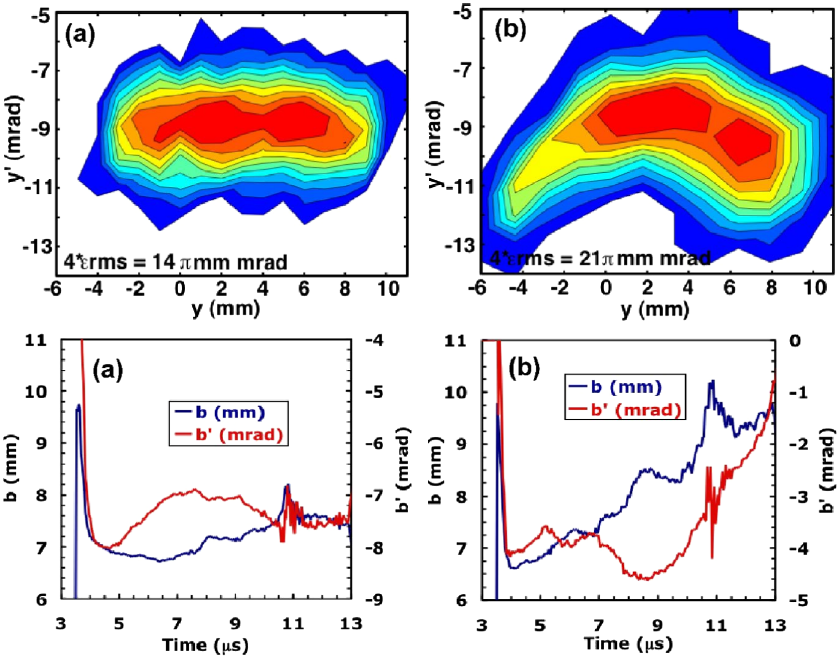
FIG. 11. (Color) Top row: measured sheared phase space distribution; bottom row: measured envelope as a function of time for: (a) clearing case; (b) grounded case; all 40 cm downstream of the exit of four solenoids ( z (cid:5) 290 cm